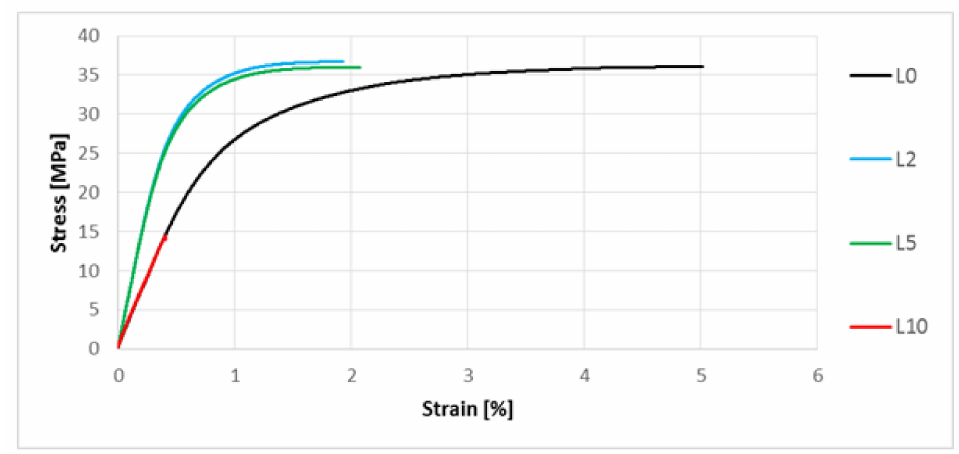
Figure 10. Stress–strain characteristics for composites with unmodified and modified flax fibers exposed to 2%, 5% and 10% NaOH